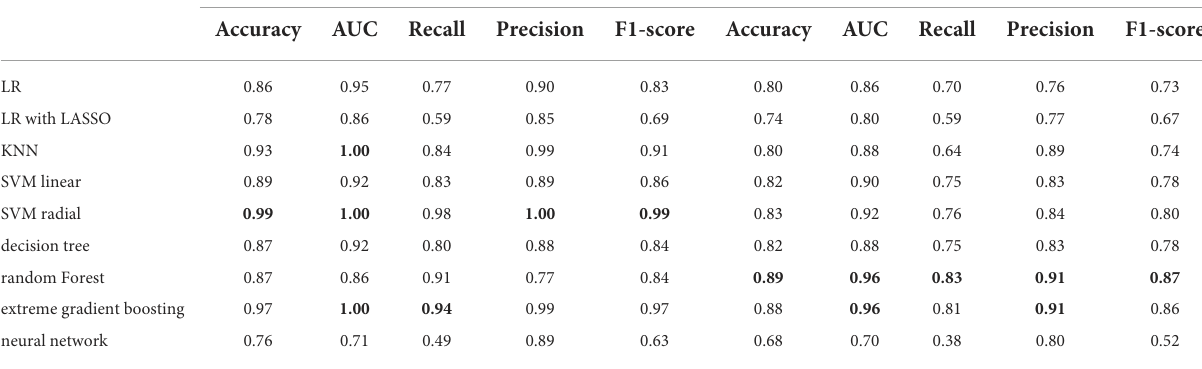
TABLE 3 The contrast of different machine learning models